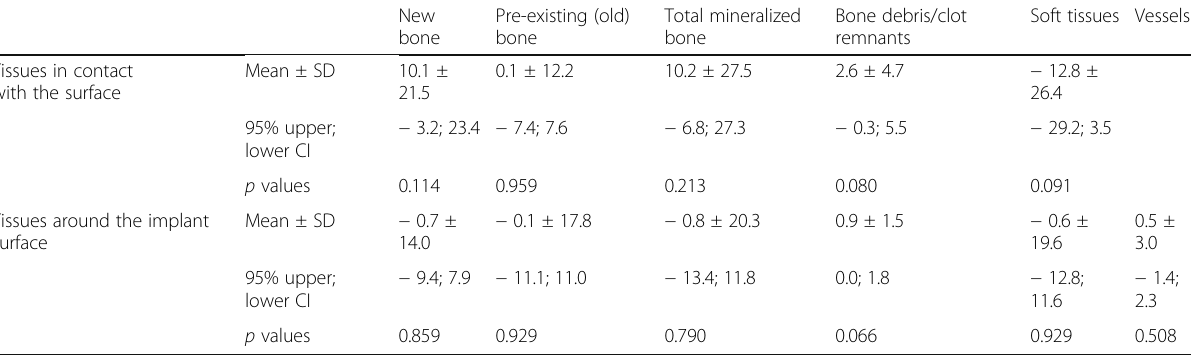
Table 2 Percentages of tissues on and around the implant surface after 8 weeks of healing. Means, standard deviations, and 95% confidence intervals of the differences between means of ~ 30 and < 10 Ncm sites ( n = 11)